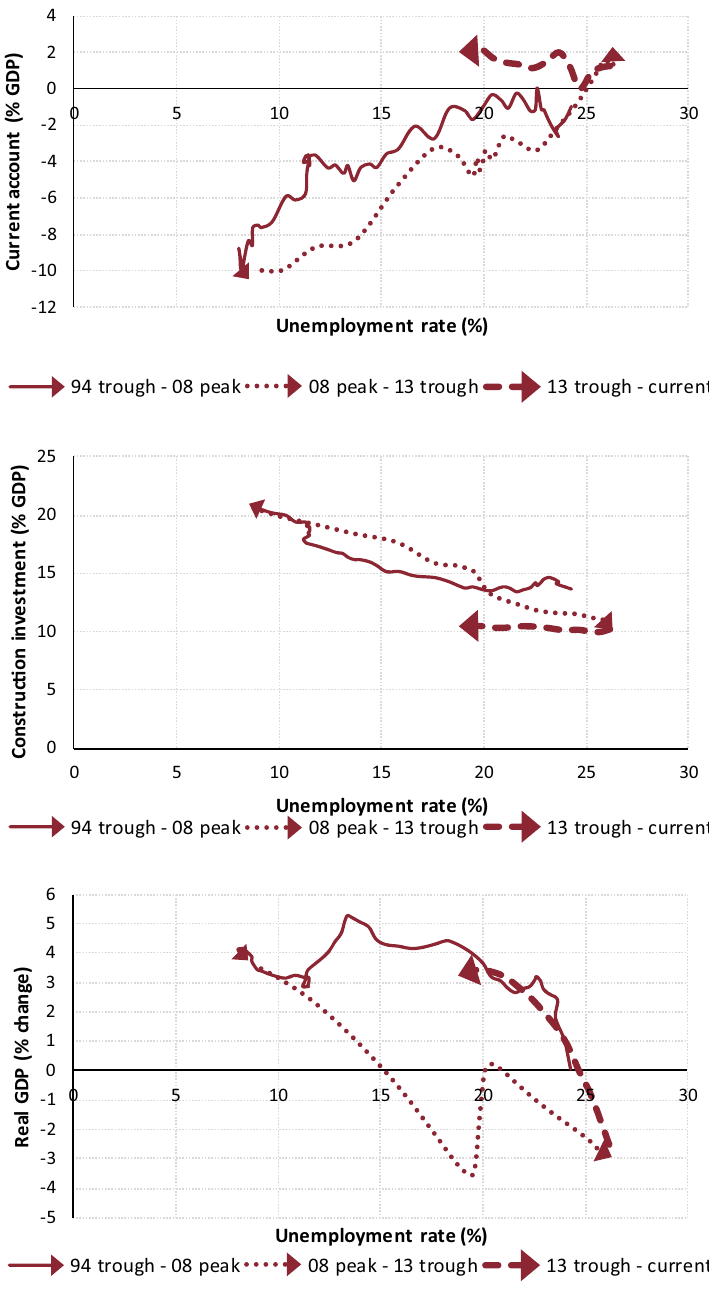
Fig. 4 Selected variables over the last cycle. Source : INE, Bank of